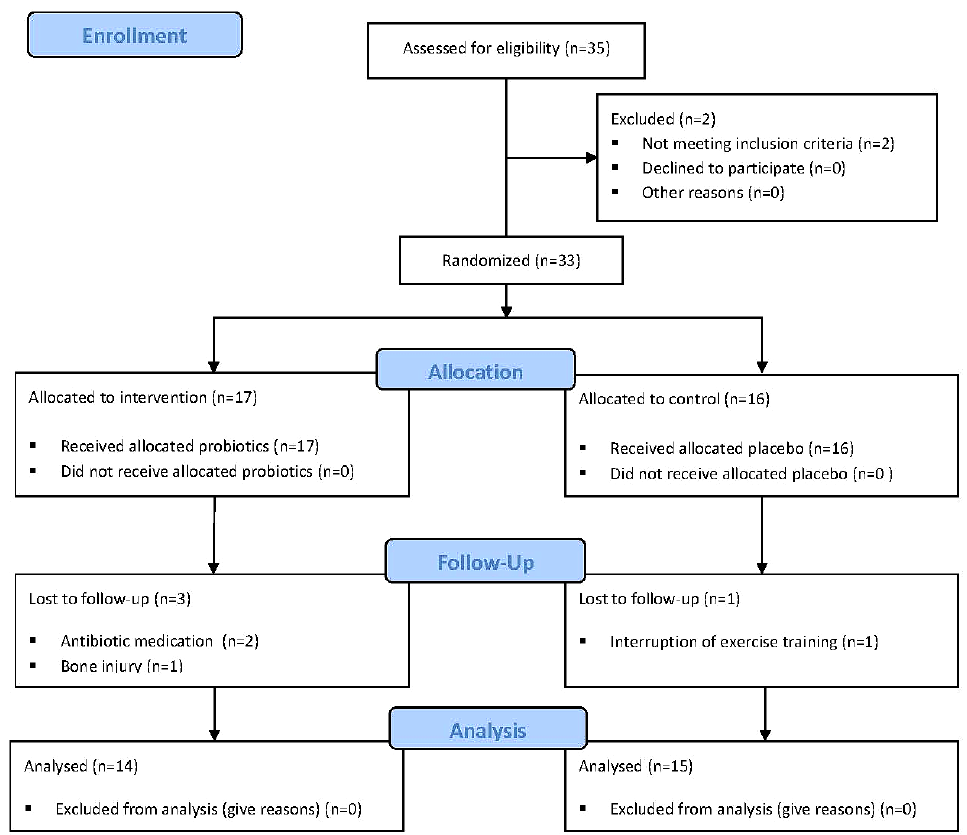
Figure 1. Flow of participations through each stage of the trial.